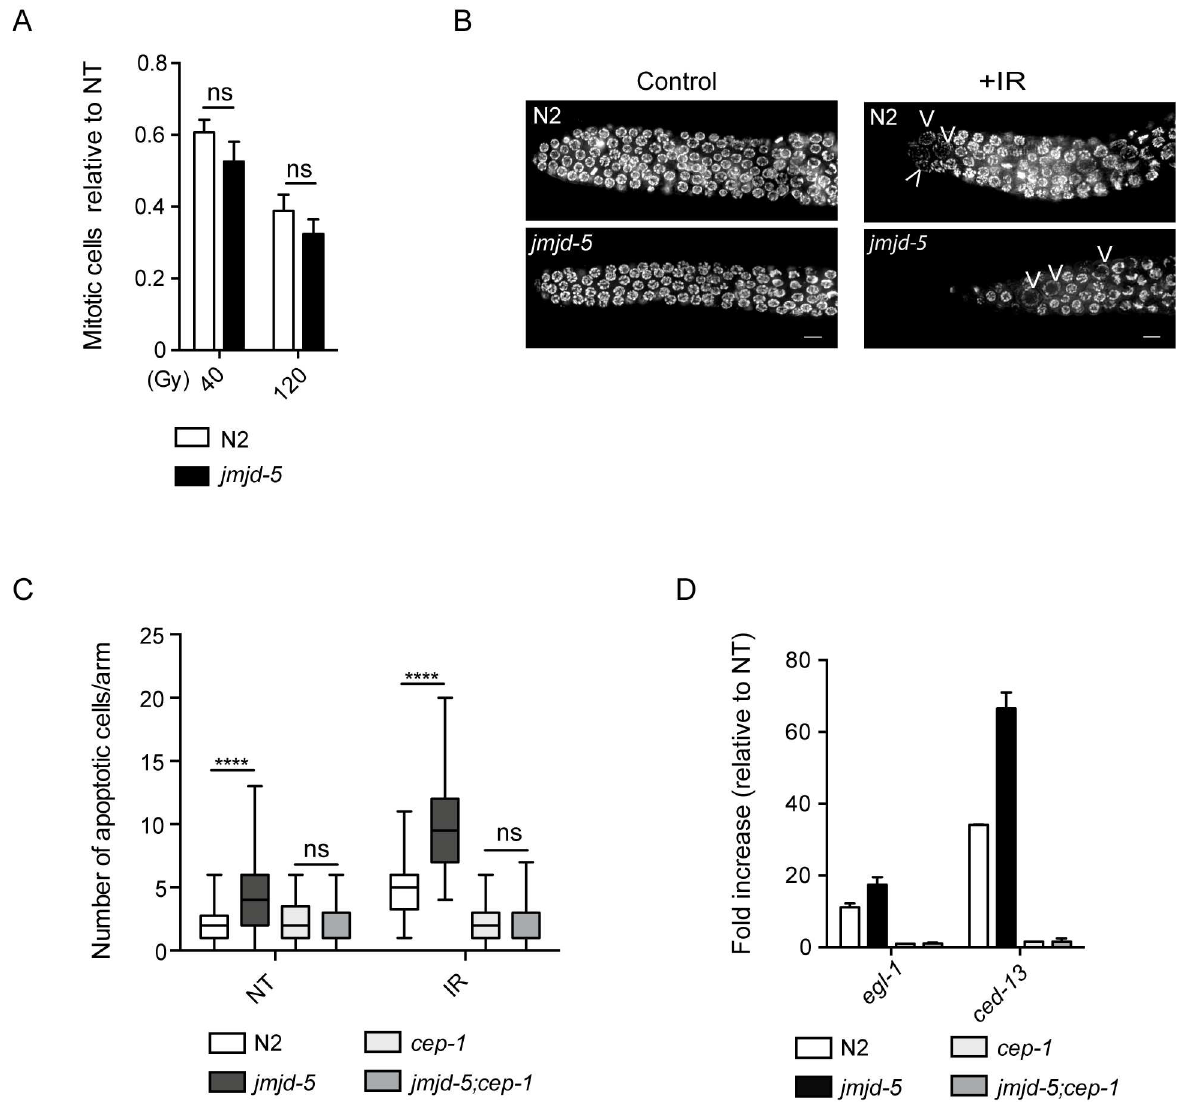
Fig 2. jmjd-5 is not required for DNA damage checkpoints activation. (A) Number of mitotic cells in N2 and jmjd-5(tm3735) after irradiationof youngadults with 40 and 120 Gy, counted 24 h after IR, relativeto the non treated (NT) animals. (B) Representative images of germlines dissected from N2 and jmjd-5 animals, 24 hours after irradiationwith 0 (control) or 80 Gy (+IR), stained with DAPI. Arrowheads indicatearrested and enlargednuclei.Scale bar: 5 μ m. (C) Quantificationof apoptotic cells in the indicatedstrains after stainingwith SYTO12, 24 hours after IR treatment (80Gy). NT, not treated. Between40 and 78 animalswere scored for genotypeand condition. **** p < 0.0001, n.s. = not significant,with two-tailed,unpairedt-test. (D) RelativemRNA expressionlevels of the pre- apoptotic genes egl-1 and ced-13 in the indicatedstrains, 24 hours after IR treatment, measuredby qPCR. Valuesare normalized to untreated samples and act-1 is used as internalcontrol. Graph is an averageof two biological independentexperiments ± sem. cep-1 (gk138) is used as